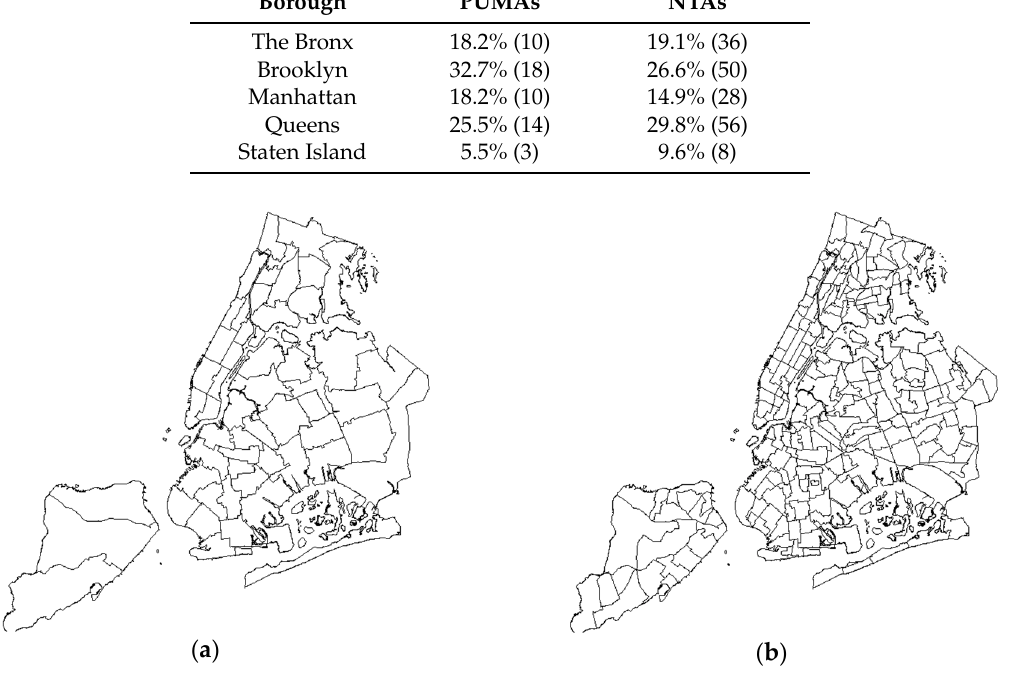
Figure 1. ( a ) Map of PUMAs in New York City; ( b ) Map of NTAs in New York City.